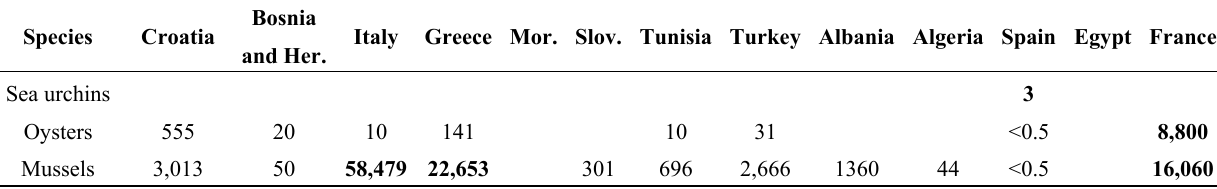
Table 3. Production in the Mediterranean Sea for mussels, oysters and urchins. (2007, metric tons, source: